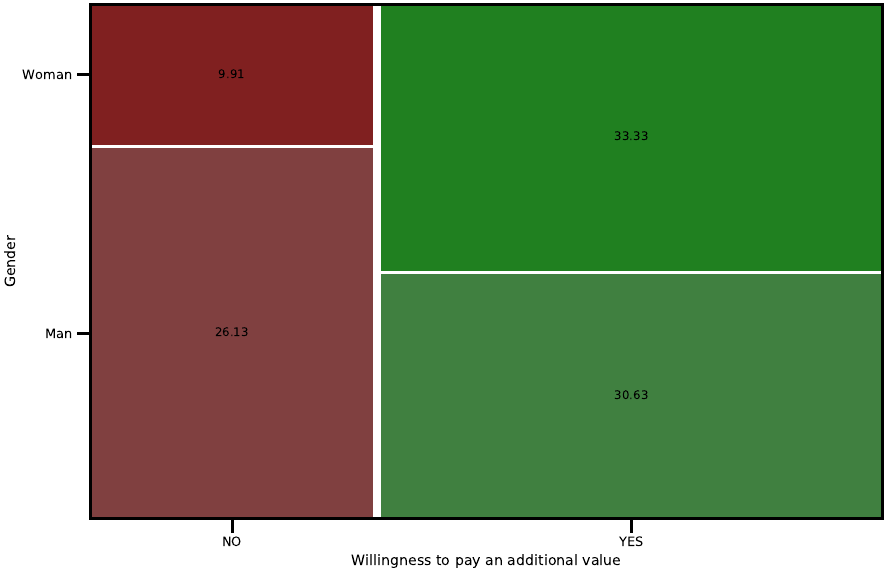
Figure 3. Mosaic plot of the willingness to pay an additional value based on gender. A Pearson’s chi-squared test was performed to determine whether there is a statistically significant difference between the expected frequencies and the observed frequencies for categorical variables in a contingency table, such as Gender/Willingness to pay extra [59]. Table 4 depicts the observed and expected frequencies (in